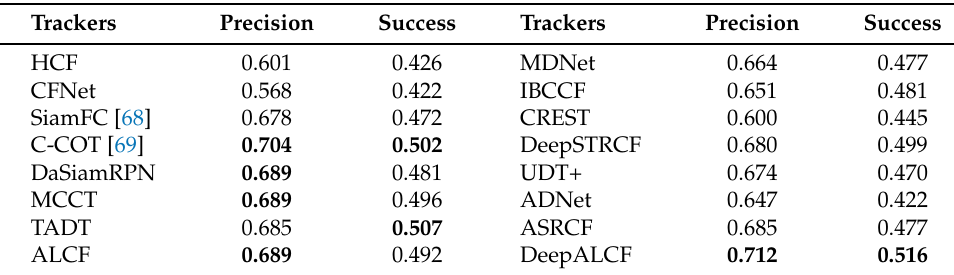
Table 6. Overall evaluation of ALCF and some other state-of-the-art trackers on UAV123@10fps [40] ( top 3 in bold